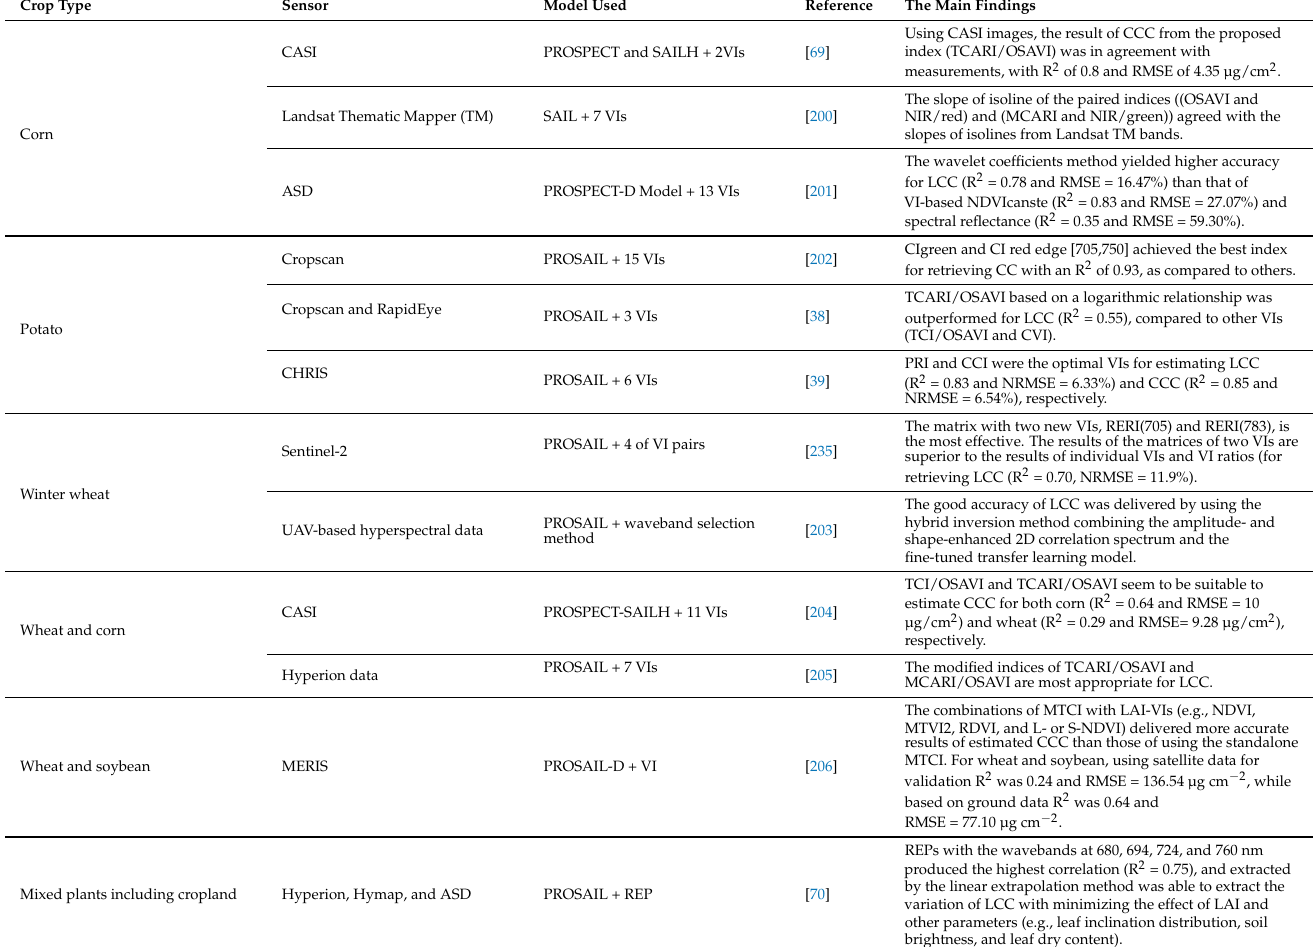
Table A3. Summary of CC prediction using a parametric